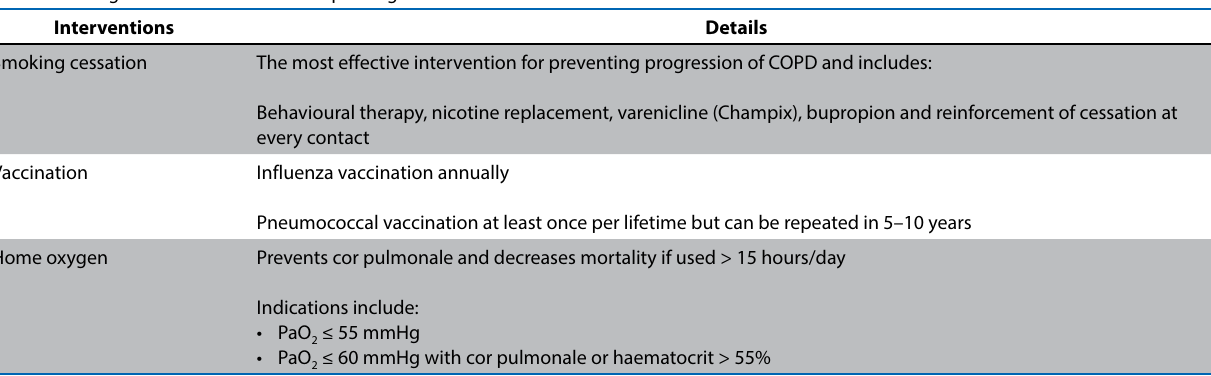
Table 5. Management interventions that prolong survival Interventions Details Smoking cessation The most effective intervention for preventing progression of COPD and includes: Behavioural therapy, nicotine replacement, varenicline (Champix), bupropion and reinforcement of cessation at every contact